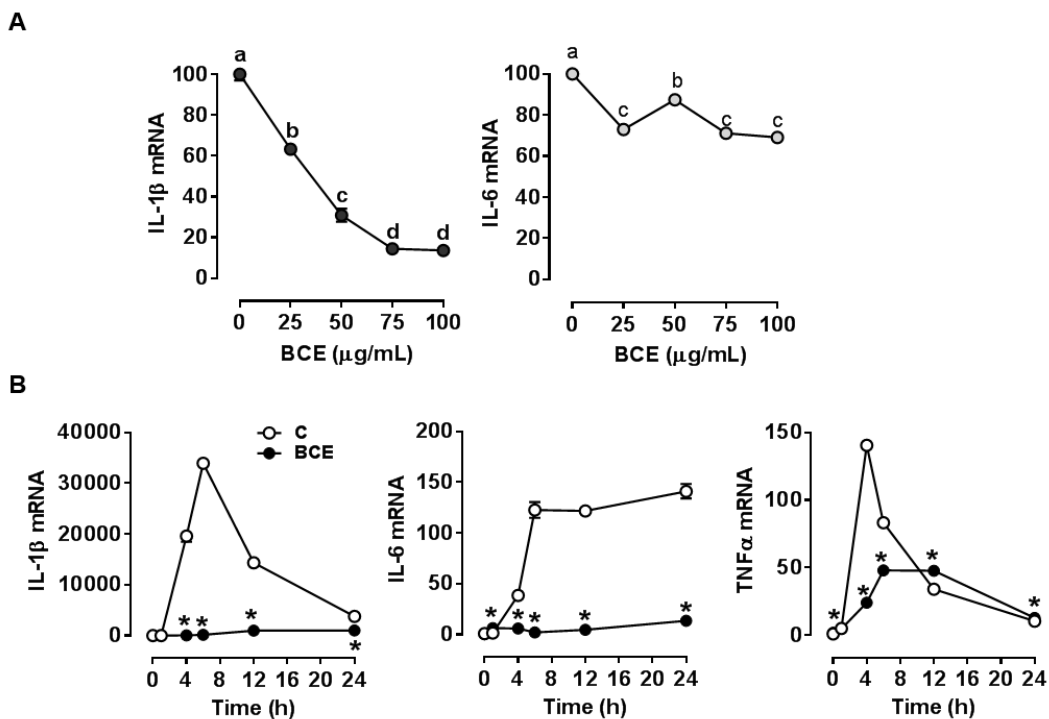
Figure 1. E ff ect of blackcurrant extract (BCE) on the expression of inflammatory genes in RAW 264.7 macrophages. ( A ) mRNA levels of interleukin-1 β (IL-1 β ) and IL-6 in RAW 264.7 macrophages. Cells were pre-treated with 0 (control; C), 25, 50, 75, or 100 µ g / mL of BCE for 24 h, and then stimulated with 100 ng / mL of lipopolysaccharide (LPS) for 6 h. ( B ) mRNA levels of IL-1 β , IL-6, and tumor necrosis factor α (TNF α ) in RAW 264.7 macrophages. Macrophages were pre-treated with 0 (control; C) or 50 µ g / mL of BCE for 24 h and then stimulated with 100 ng / mL of LPS for 0, 1, 4, 6, 12, or 24 h. Data were normalized by no LPS control. Data are shown as mean ± SEM. Di ff erent letters show significant di ff erences ( p < 0.05). *, p < 0.05 vs. control.